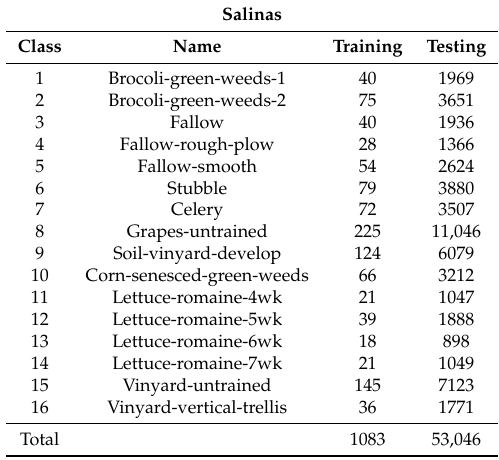
Table 2. Number of training and testing samples for the Salinas